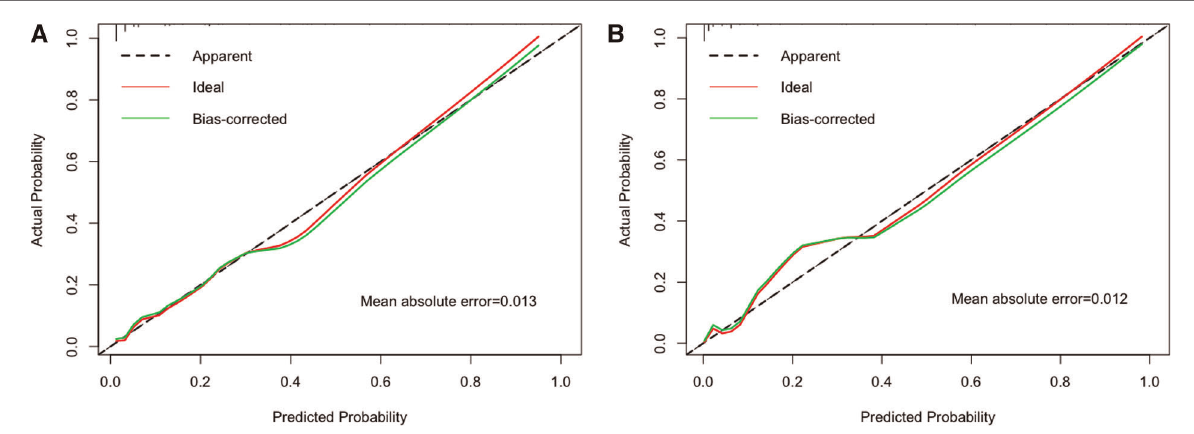
FIGURE 4 The calibration method with bootstrapping was used to illustrate the association between actual apnea and predicted apnea. Calibration plots showed the apparent (actual), bias-corrected (adjusted), and ideal (100% agreement) curves with bootstrapping samples. Bootstrapping involved 1,000 repetitions. Nomogram-predicted probability of apnea was plotted on the x -axis; the observed probability of apnea was plotted on the y - axis. The diagonal dotted line represents a perfect prediction by an ideal model. The solid line represents the performance of the nomogram, of which a closer fi t to the diagonal dotted line represents a better prediction. ( A ) Training cohort; ( B ) external validation cohort.